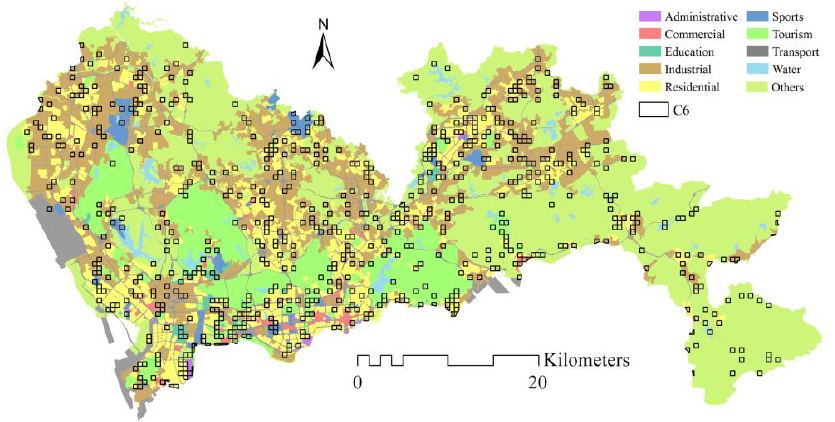
Figure 11. Spatial distribution of identified functional cluster C